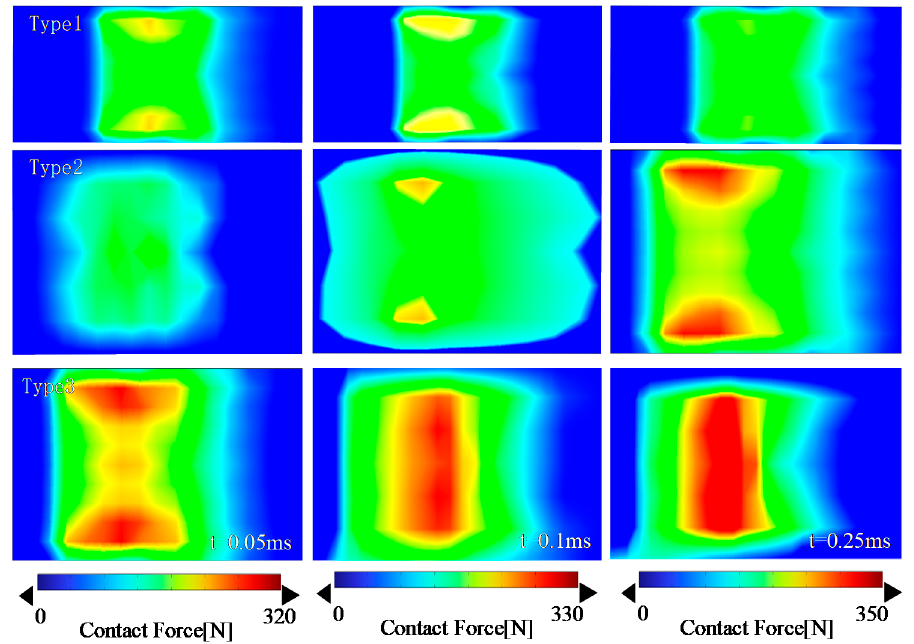
Figure 10. Distribution of contact force at different time.